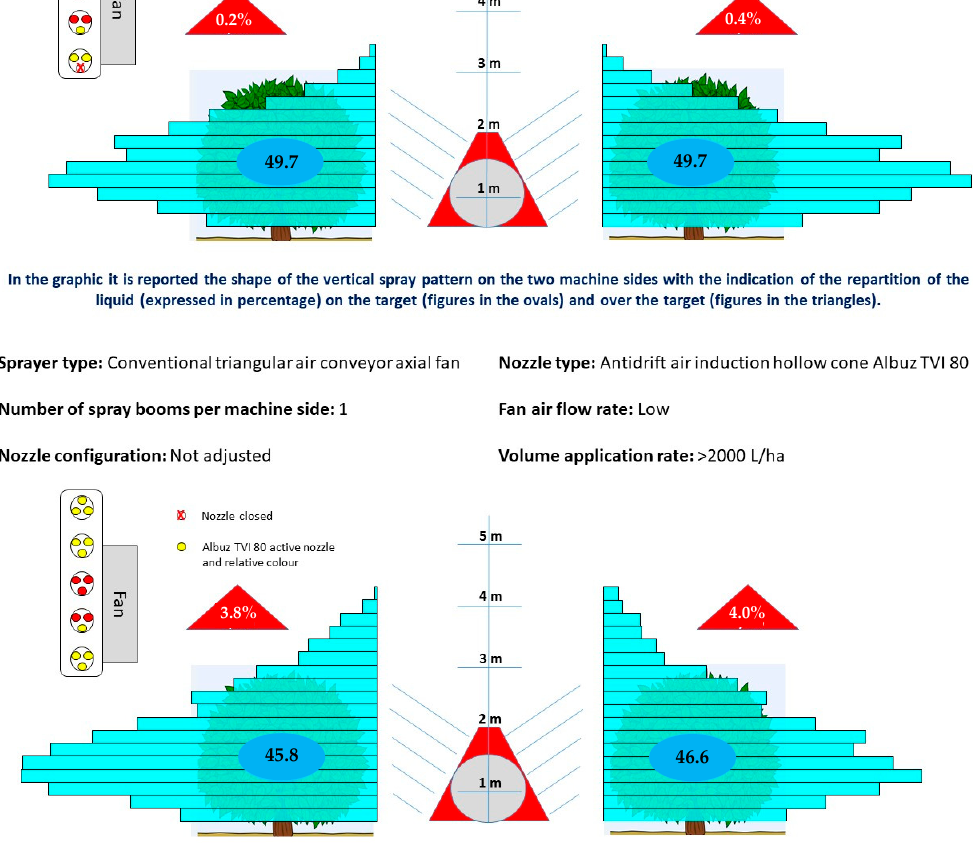
Figure 26. Citrus VESPA output for the example. Top image: Triangular outlet fan, 1 boom sprayer, Antidrift nozzles, low fan speed, ADJUSTED nozzle configuration and spray volume rate >2000 L/ha; Bottom image: Triangular outlet fan, 1 boom sprayer, Antidrift nozzles, low fan speed, NOT AD- JUSTED nozzle configuration and spray volume rate >2000